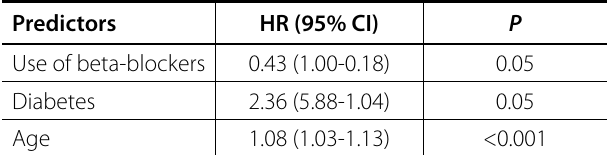
Table 4. Predictors for cardiovascular survival in patients who underwent CABG for stable angina